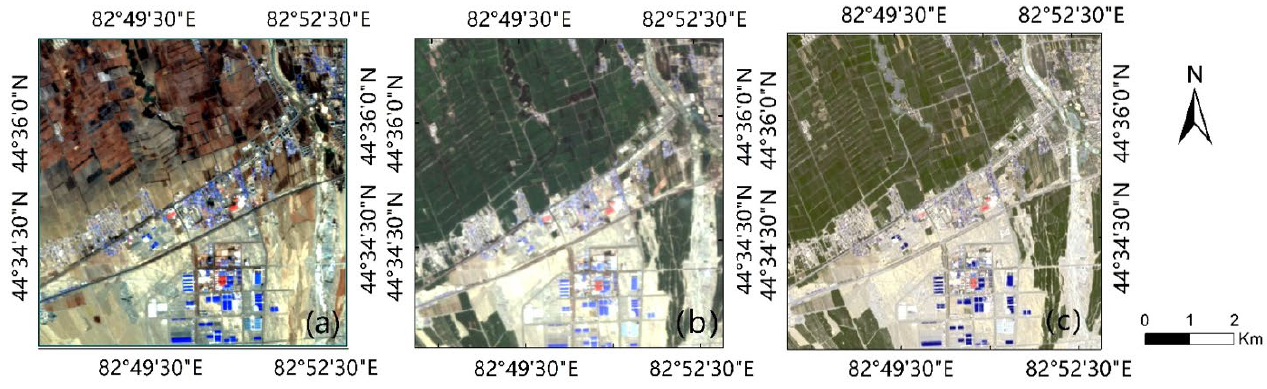
Figure 4. Color composite of GF-6 images of region A (RGB:3, 2, 1) ( a ) 9 April 2019, ( b ) 24 July 2019, ( c ) 26 August 2019.